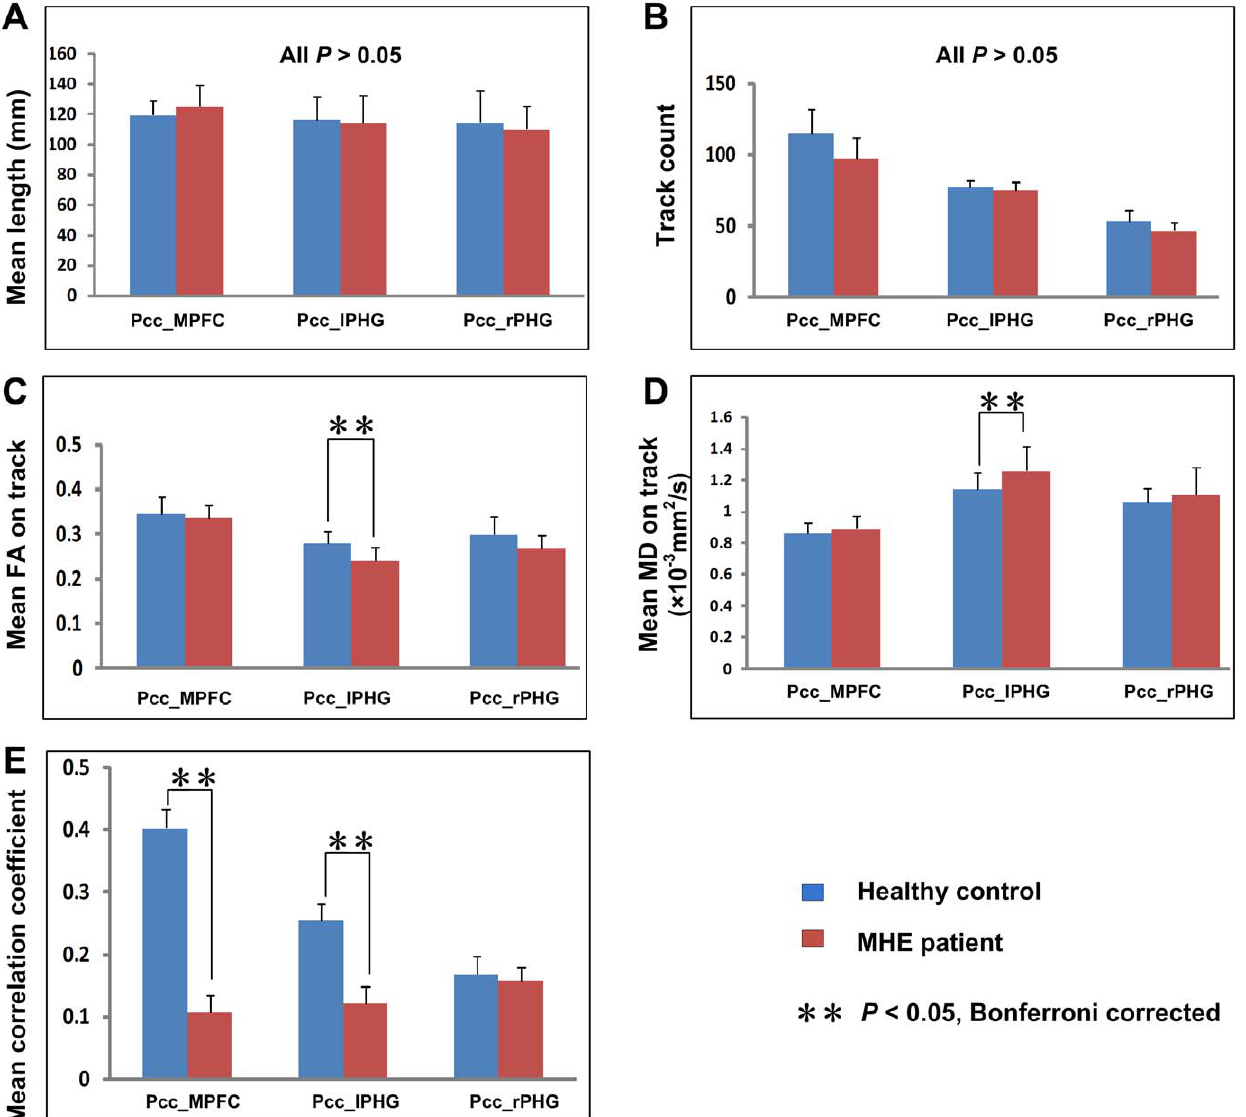
Figure 4. Comparison of structural and functional connectivity between MHE patients and healthy controls. Compared to the healthy controls, MHE patients show both decreased FA and increased MD in the tract connecting the PCC/PCUN to left PHG, and decreased functional connectivity between the PCC/PCUN and left PHG, and MPFC. For each connection, differences are setting at the significant level of corrected P , 0.05 (marked with **) with Bonferroni correction. Error bars represent the standard deviation of the measurements. MHE=minimal hepatic encephalopathy; PCC/PCUN=posterior cingulate cortex/precuneus; PHG=parahippocampal gyrus; MPFC=medial prefrontal cortex; FA=fractional anisotropy; MD=mean